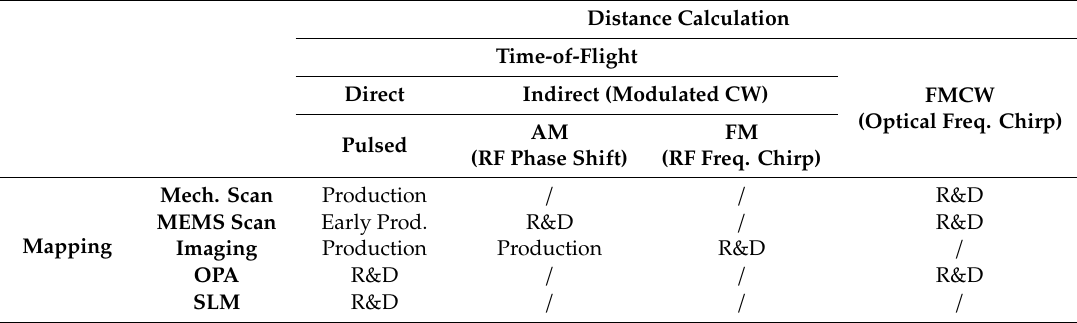
Table 1. Status of popular LiDAR solutions for autonomous driving, ADAS and consumer 3D sensing with respective to the design choices in distance calculation and scene